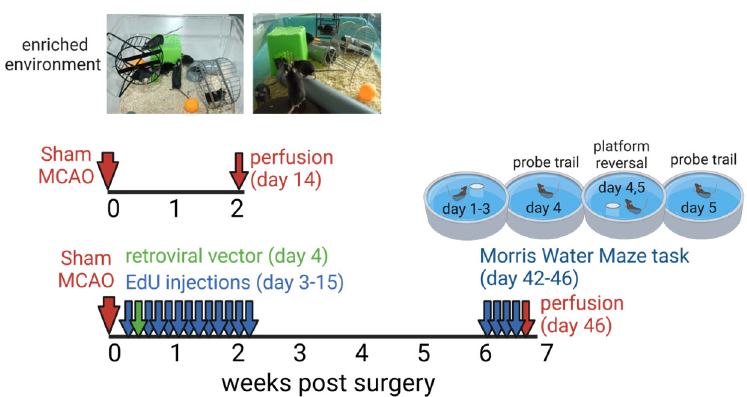
Figure 1. Experimental design. All animals were randomly assigned to 4 groups: 2 groups underwent a sham surgery and 2 groups an MCAO with survival period of 2 or 7 weeks. Subsequently, animals were transferred to a standard cage (Sham-SD; MCAO-SD) or to an EE housing (Sham-EE; MCAO-EE). Mice with a survival period of 7 weeks were injected with the proliferation marker EdU over a period of 3 to 15 days post-surgery and, on day 4, with the retroviral vector. At six weeks post-surgery, the spatial learning abilities were tested with the Morris water maze task over a period of 5 days. This was followed by transcardial perfusion, tissue collection and analysis. Created with BioRender.com.